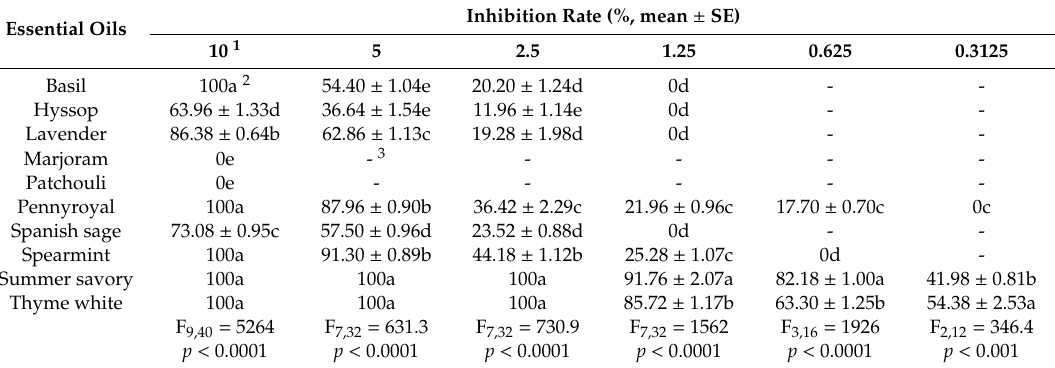
Table 3. Fumigant antifungal activities of Lamiaceae plant essential oils against R. solani